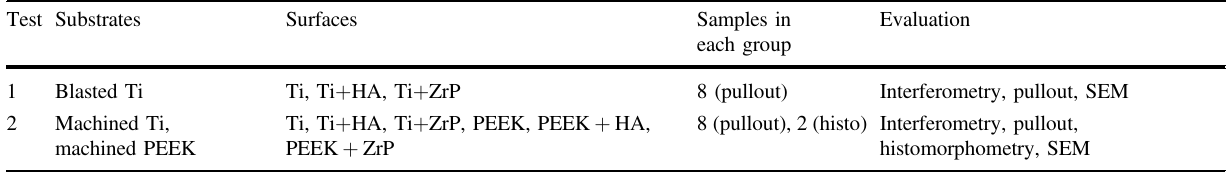
Table 1 Overview of ex vivo tests Test